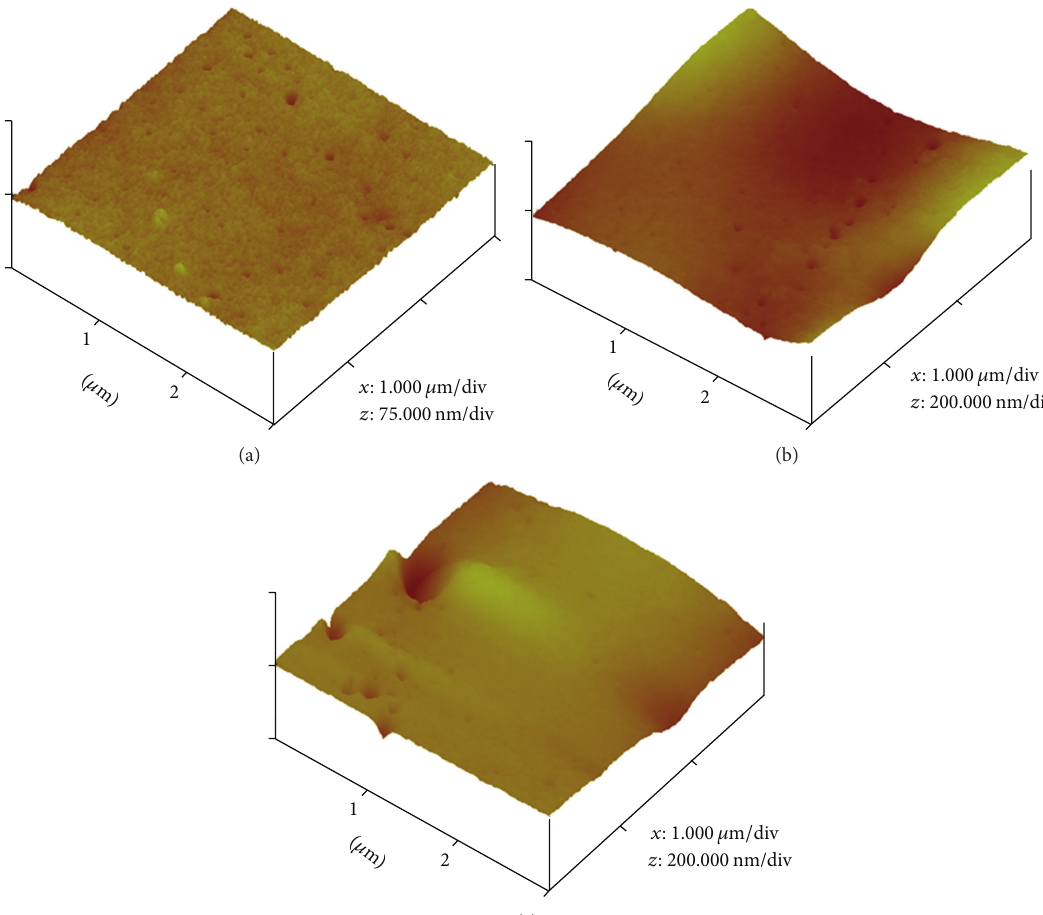
Figure 3: AFM images of the topographic and three-dimensional structures obtained for (a) chitosan films, (b) chitosan film with essential oil of clove, and (c) chitosan film with functional extract of clove.